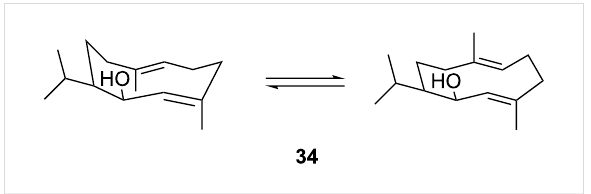
Figure 8: Structure of the two interconvertible conformers of (1(10) E ,4 E )-germacradien-6-ol ( 34 ) studied with extensive 13 C labeling